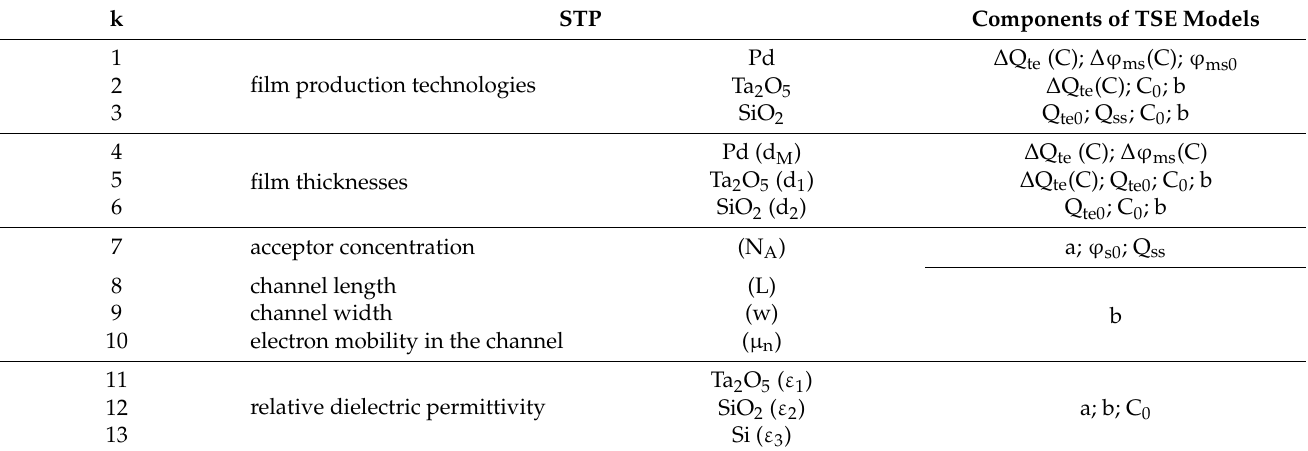
Table 2. The effect of STP p k on the components of TSE